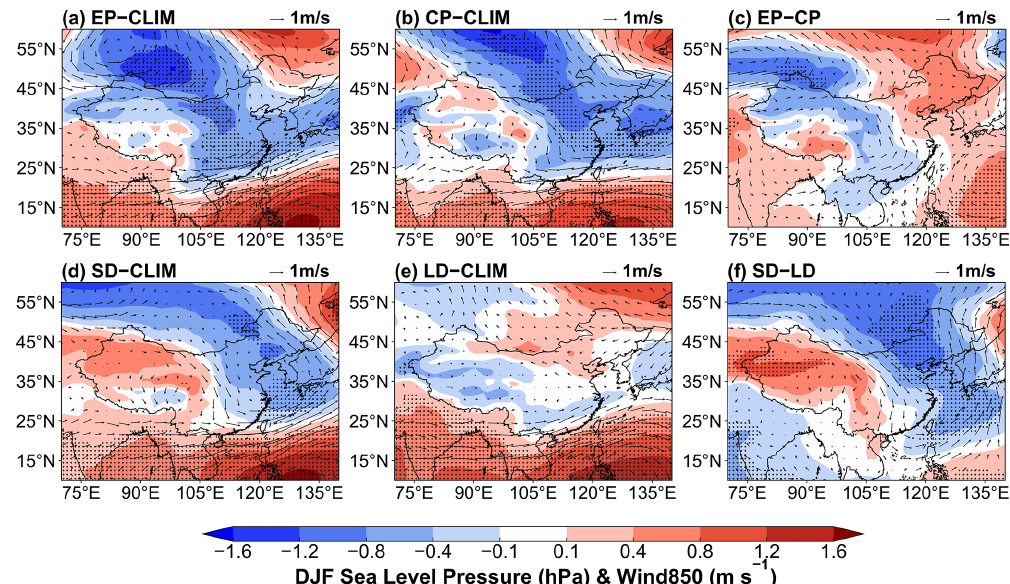
Figure 4. Composite differences in DJF mean sea level pressure (SLP; shaded; units: hPa) and winds at 850hPa (WIND850; vector; units:ms − 1 ) between EP and CLIM in (a) , CP and CLIM in (b) , EP and CP in (c) , SD and CLIM in (d) , LD and CLIM in (e) , and SD and LD in (f) . The stippled areas indicate statistical significance with 90% confidence from a two-tailed t